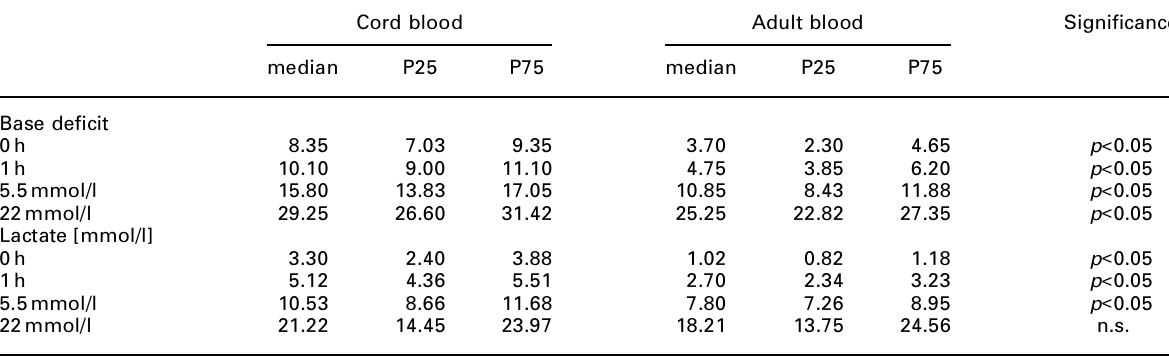
Table 1. Base deficit and lactate concentration for cord and adult blood at 0h, 1h, and after equilibration with lactate (5.5mmol/l and 22mmol/l) Cord blood